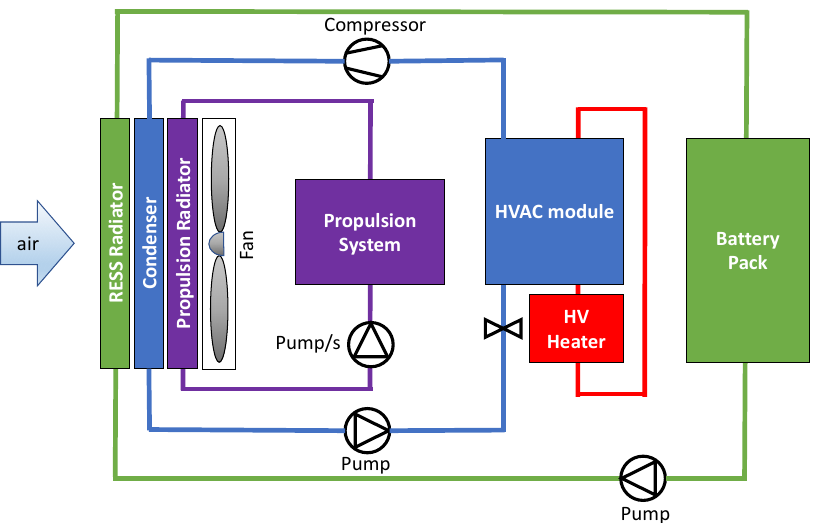
Figure 1. Cooling system circuits: AC refrigerant loop (blue), HVAC coolant loop (red), propulsion loop (purple), RESS loop (green).